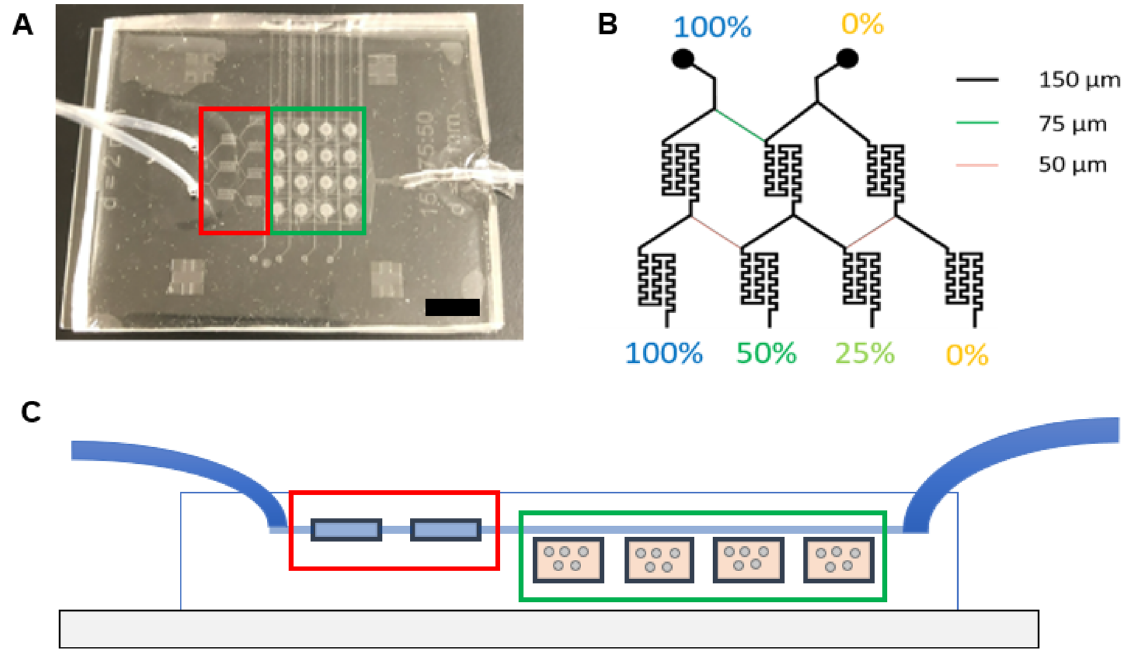
Figure 1. Microfluidic device design. ( A ) Photo of the microfluidic device with the inlet (left-hand side of image) and outlet (right-hand side of image) tubing. Black scale bar represents 1 cm. ( B ) Channel widths of the microchannels and the concentration dilutions generated with these channel widths. ( C ) Side view of the fabricated microfluidic devices displaying the inlet tubes (left), mixing chambers (red), cell culture chambers (green), and outlet tube